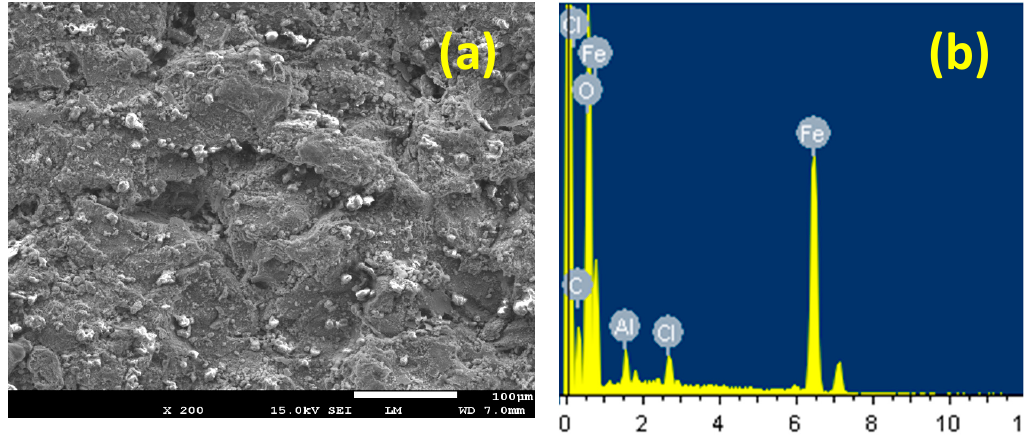
Figure 11. ( a ) The SEM image and ( b ) the corresponding energy-dispersive X-ray (EDX) spectra for uncoated PS in 4% NaCl solution for 48 h followed by fixing a potential value of − 700 mV for 40 min.